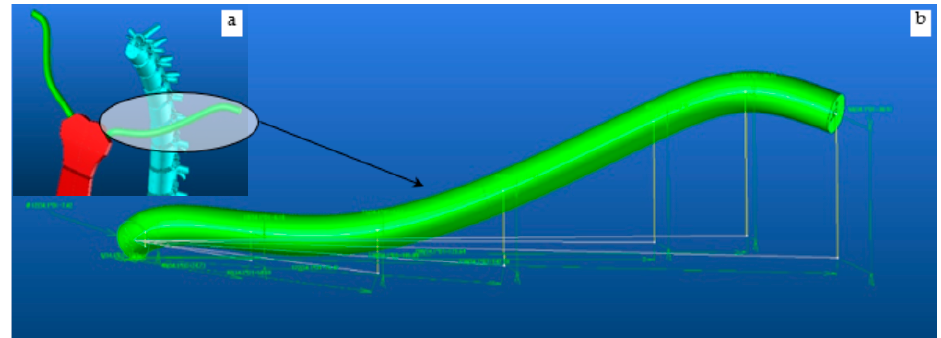
Figure 9. Adaptive scapula model ( a ) global dimension of the clavicle by the parameter D1 and ( b ) a zoomed morphology of the clavicle in 3D view.